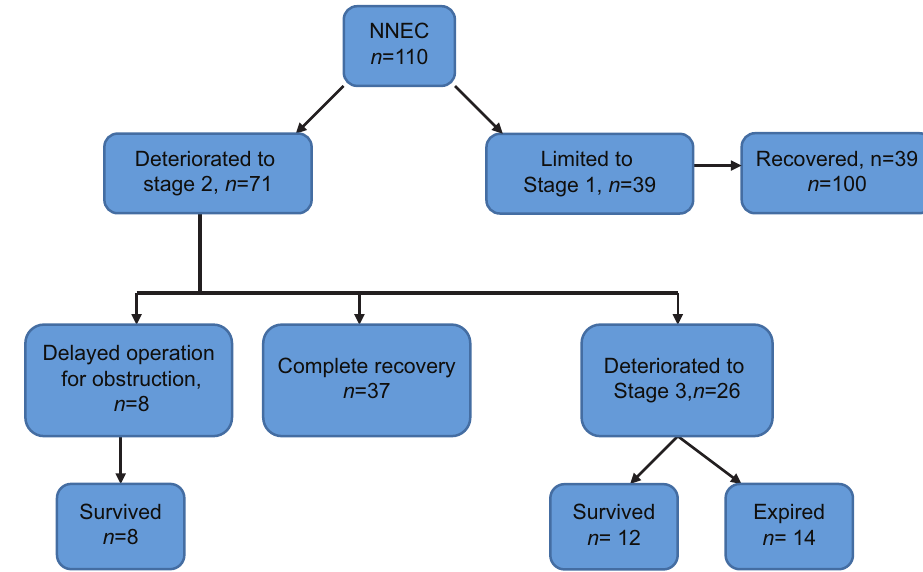
Figure 2: Flow chart showing the treatment and outcome of the 110 NNEC Table 4: Post-operative complications and causes of deaths Complications